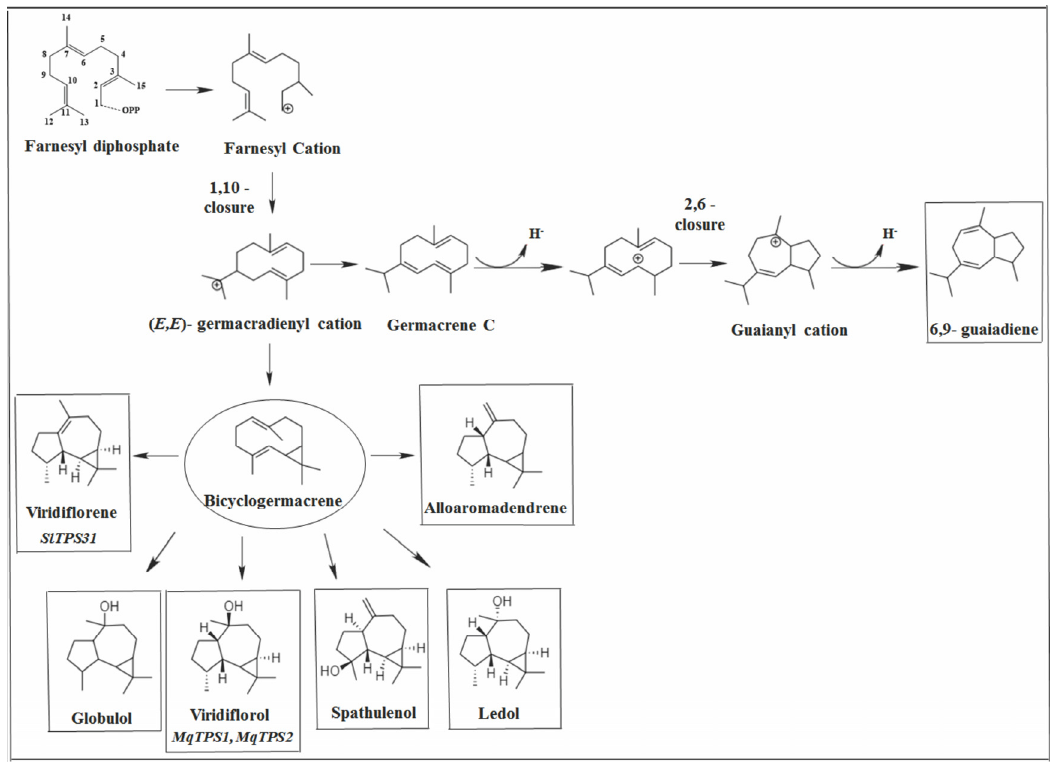
Figure 12. Types of primary cyclization of aromadrendanes, bicyclogermacrene, and